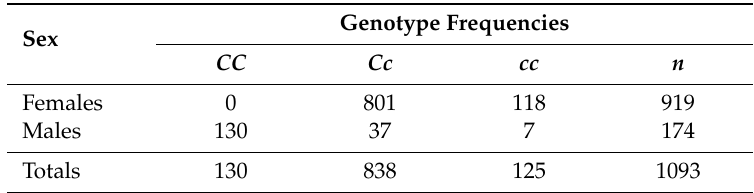
Table 4. Observed frequencies of C genotypes (corrected for penetrance *) in 19 field samples of flying D. chrysippus at Kitengela, Kenya, May 2013–September 2015